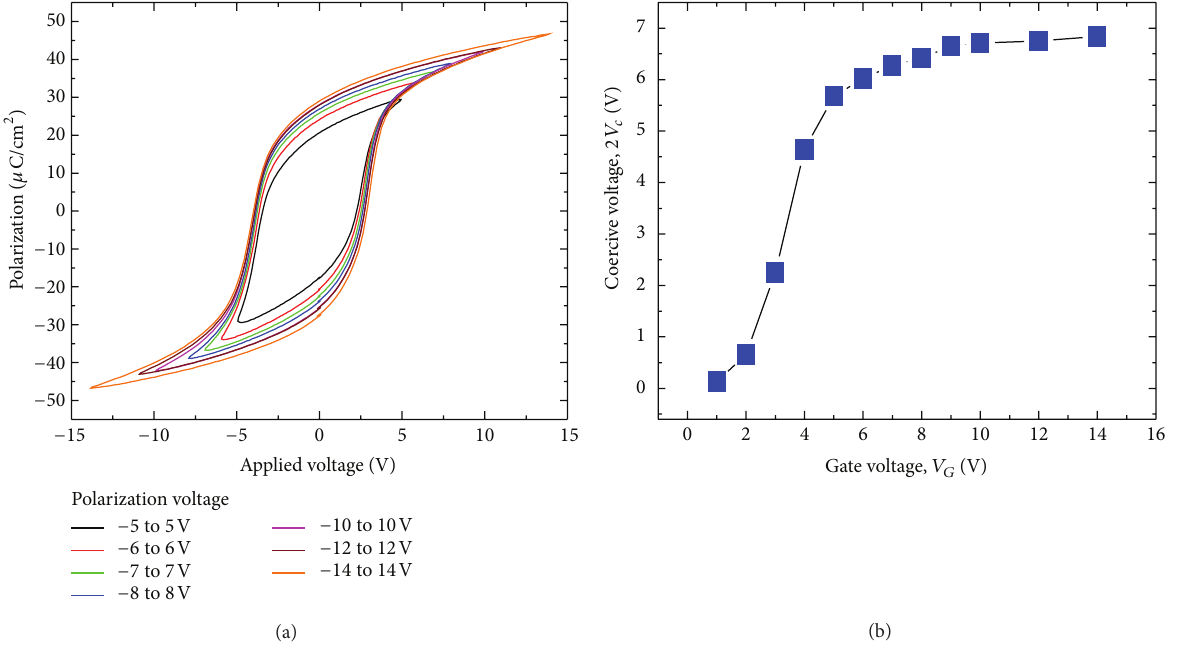
Figure 5: (a) P-V hysteresis loops and (b) the twice of the coercive voltages of the Pt/LO/PZT/Pt capacitor.